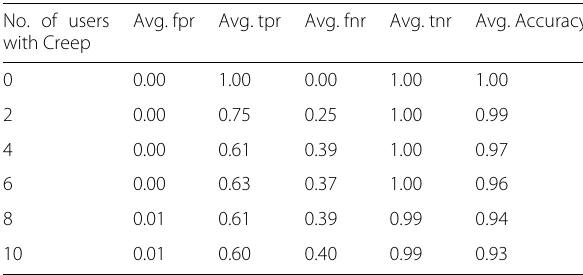
Table 5 Average results based on number of users with permission